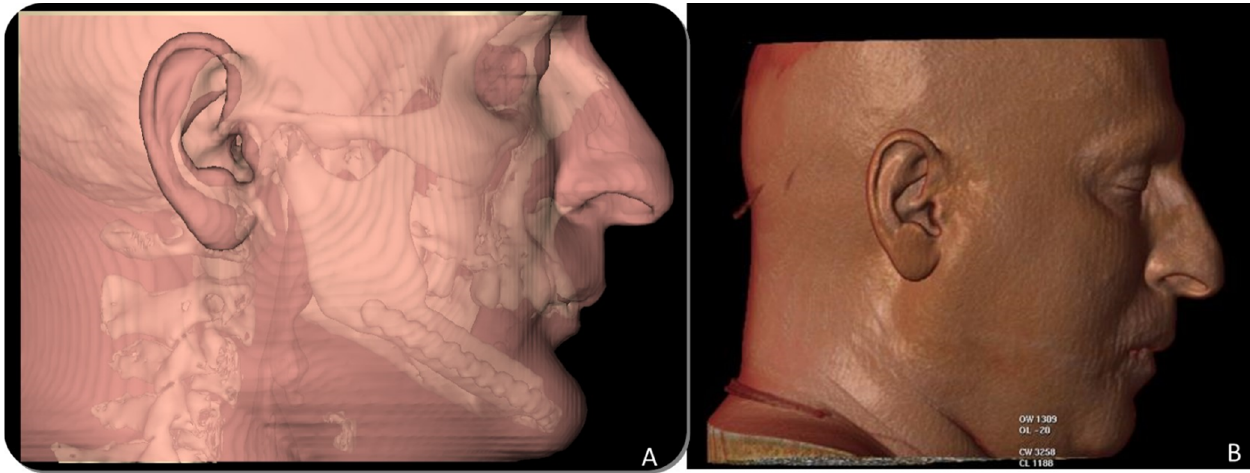
Figure 15. Aesthetic comparison. ( A ) Morphing performed through CT Scan after mandibular reconstruction with fibula free flap, showing a retrusion and collapse of the lower facial third. ( B ) Morphing performed after implant rehabilitation, demonstrating a significant aesthetic improvement after 3D reconstruction with iliac crest graft.